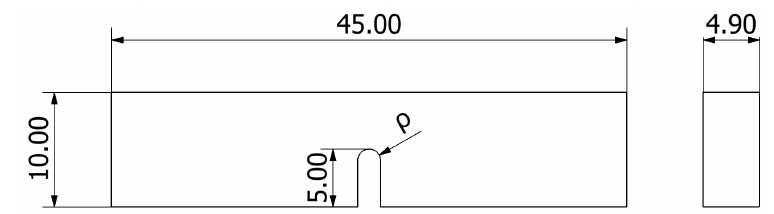
Figure 2. Schematic of fracture single edge notched bend (SENB) specimens. Dimensions in mm.